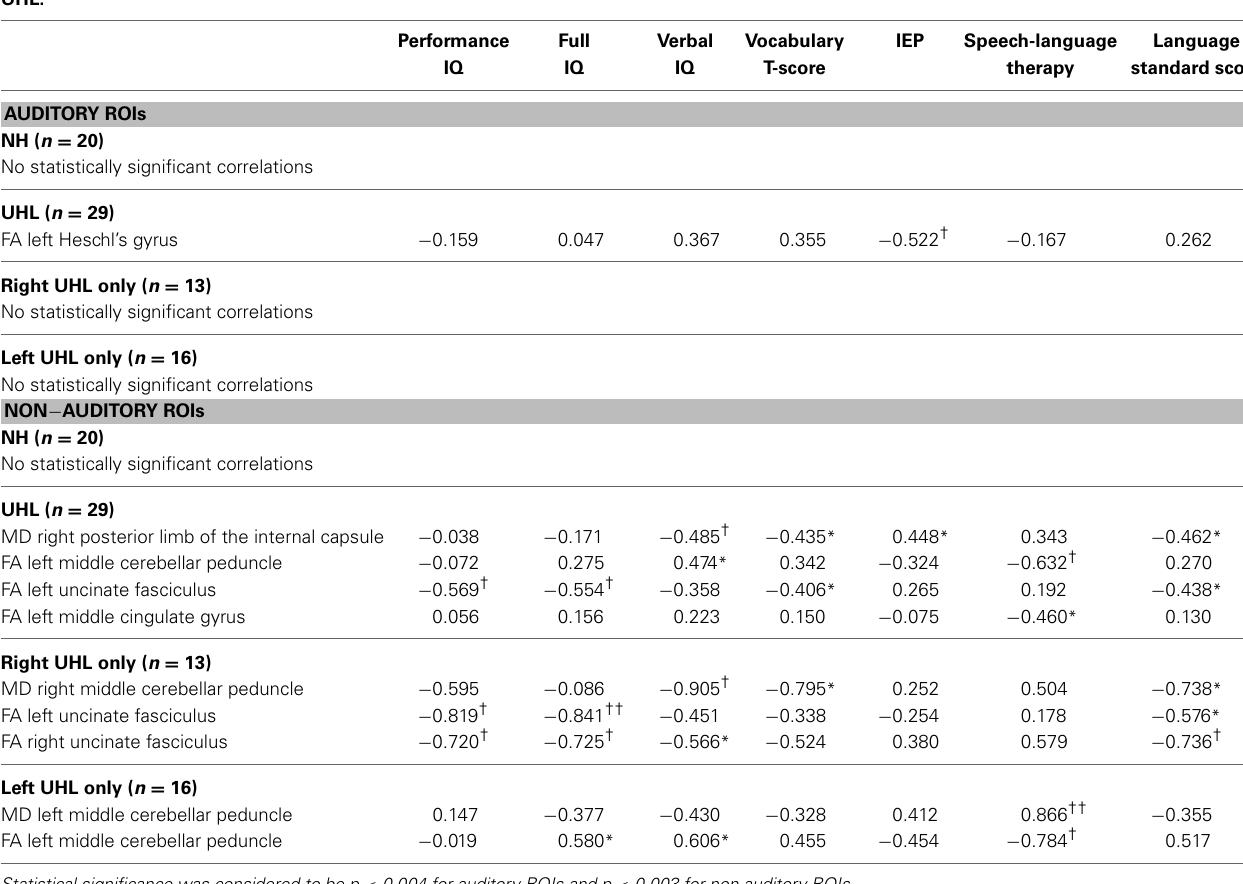
Table 6 | Spearman rho correlation values between educational outcomes and DTI parameters (fractional anisotropy, FA; mean diffusivity, MD) in auditory and non-auditory regions of interest (ROI) in participants with normal hearing (NH), unilateral hearing loss (UHL), right UHL or left